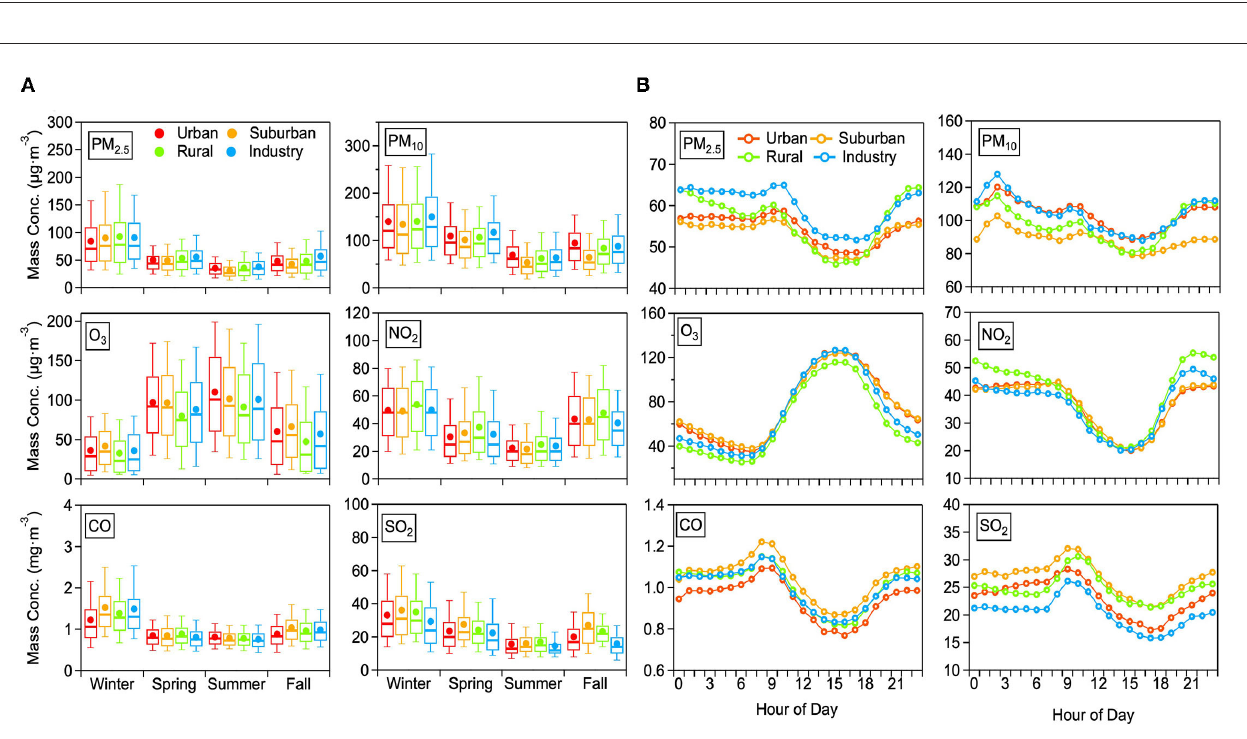
mass concentration of PM than in the other three areas in all four seasons (except for the PM 10 in summer and fall). The local source of high mass loading of PM in RA results mainly from residents cooking and straw burning. The higher PM 10 in UA compared to that in IA in summer and fall might be ascribed to the heavy traffic